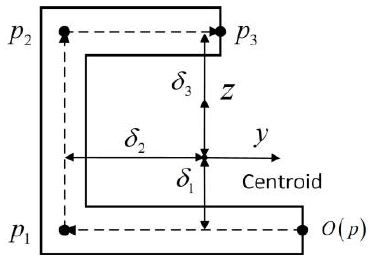
Figure 10. The sectorial coordinate of open cross-section. The sectorial axis initiates from O ( p ) to p 1 , p 2 and terminates at p 3